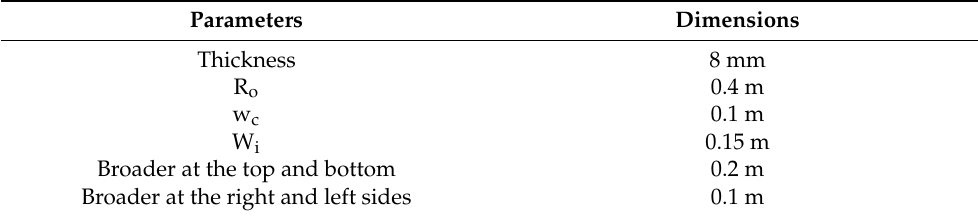
Table A10. Ring-Shaped Infill Panel Dimensions (6.5 m × 4 m).